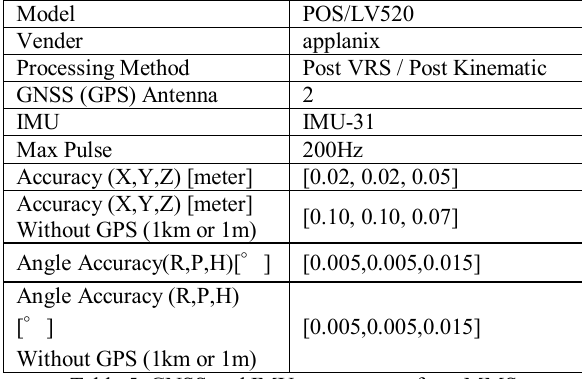
Table 5. GNSS and IMU parameters of our